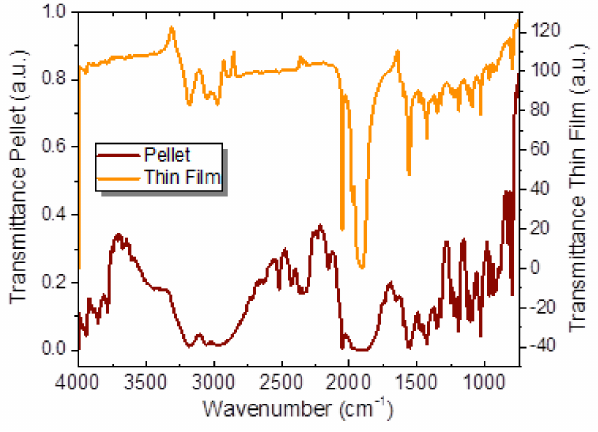
Figure 2. IR spectrum of aminocarbene 3b (3-pyridyl derivative) as KBr pellet and thin